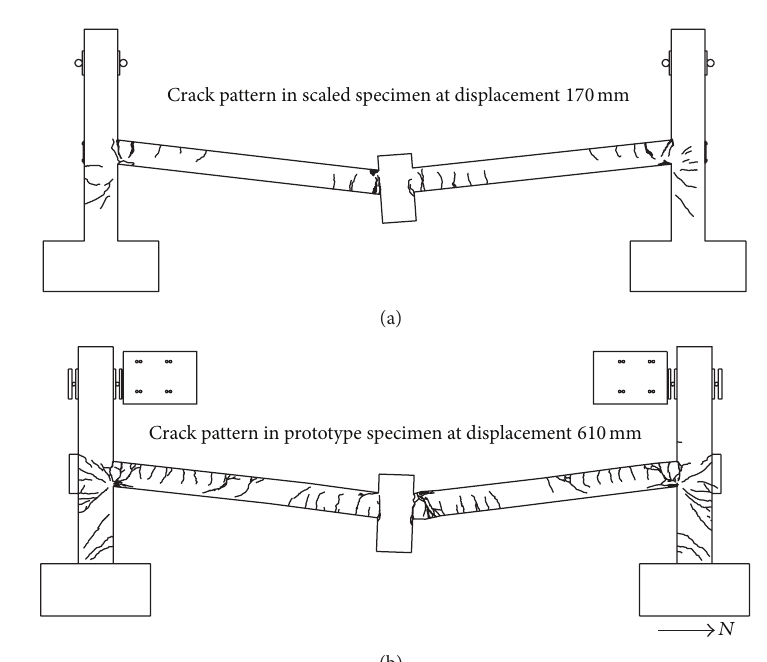
Figure 8: Comparison of crack pattern in full-scale and scaled specimens at vertical displacements of middle joint equal to 1.2 times the beam